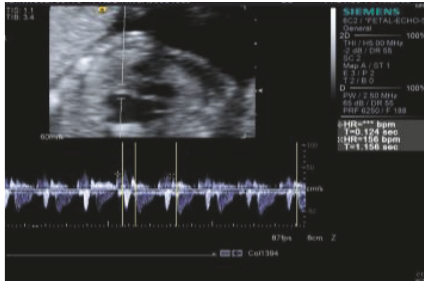
Figure 2: Normal mechanical PR interval (mPR) 10 days earlier in our case; fetal cardiac Doppler sampling the mitral inflow to aortic outflow.